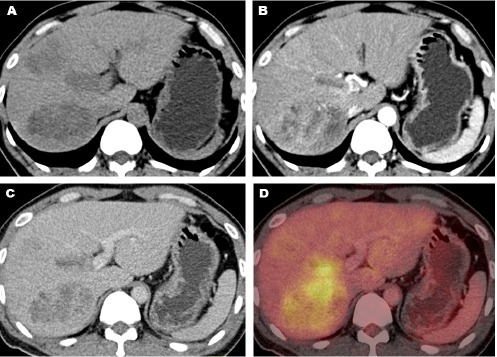
The contrast-enhanced FDG PET/CT shows a liver tumor with heterogeneous contrast enhancement and increased FDG uptake, adjacent to the right expansile thrombosed portal vein. The thrombus appeared hypodense in the non-enhanced CT (A). It showed perithrombus contrast enhancement in the arterial phase CT (B), appeared washout in the portal venous phase CT (C), and showed an increased FDG uptake in the PET/CT image (D)